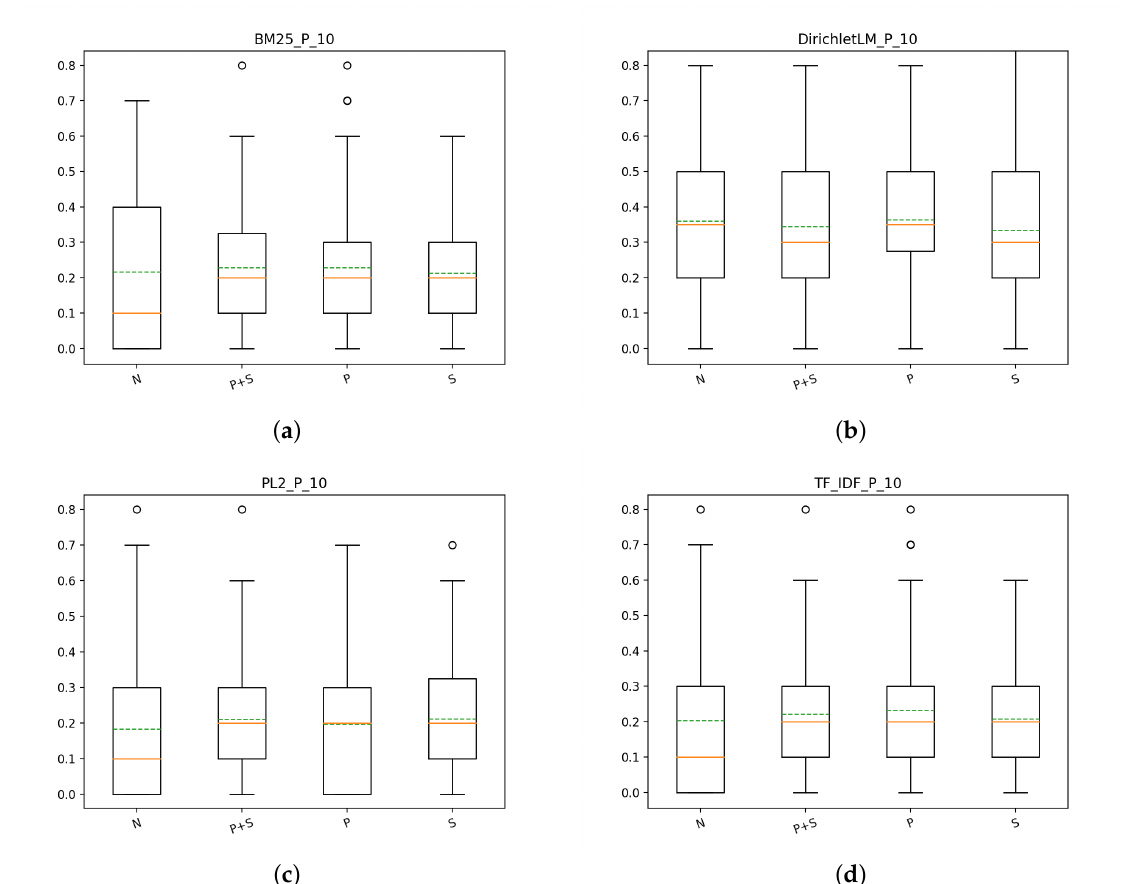
Figure 9. T1: box plots for P@10 of the different indexes for each model, with QE+RF: ( a ) precision for BM25 with different indexes, ( b ) precision for DirichletLM with different indexes, ( c ) precision for PL2 with different indexes, ( d ) precision for TF-IDF with different indexes. Table 5. T1: NDCG at various cut offs and Recall@R for the different models with QE+RF. The highest values are in